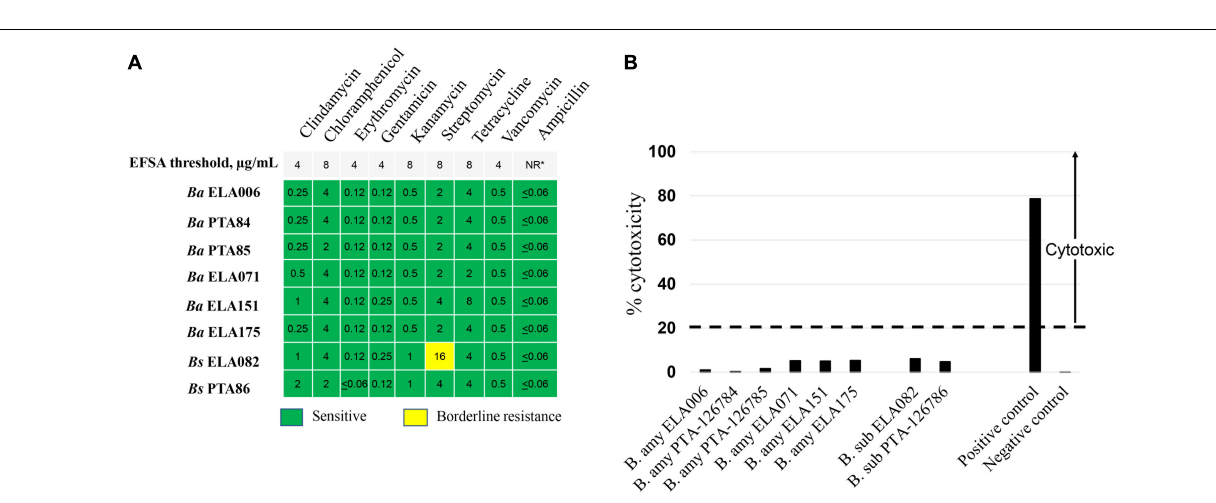
Pseudomonas aeruginosa ATCC 27853 and Staphylococcus aureus ATCC